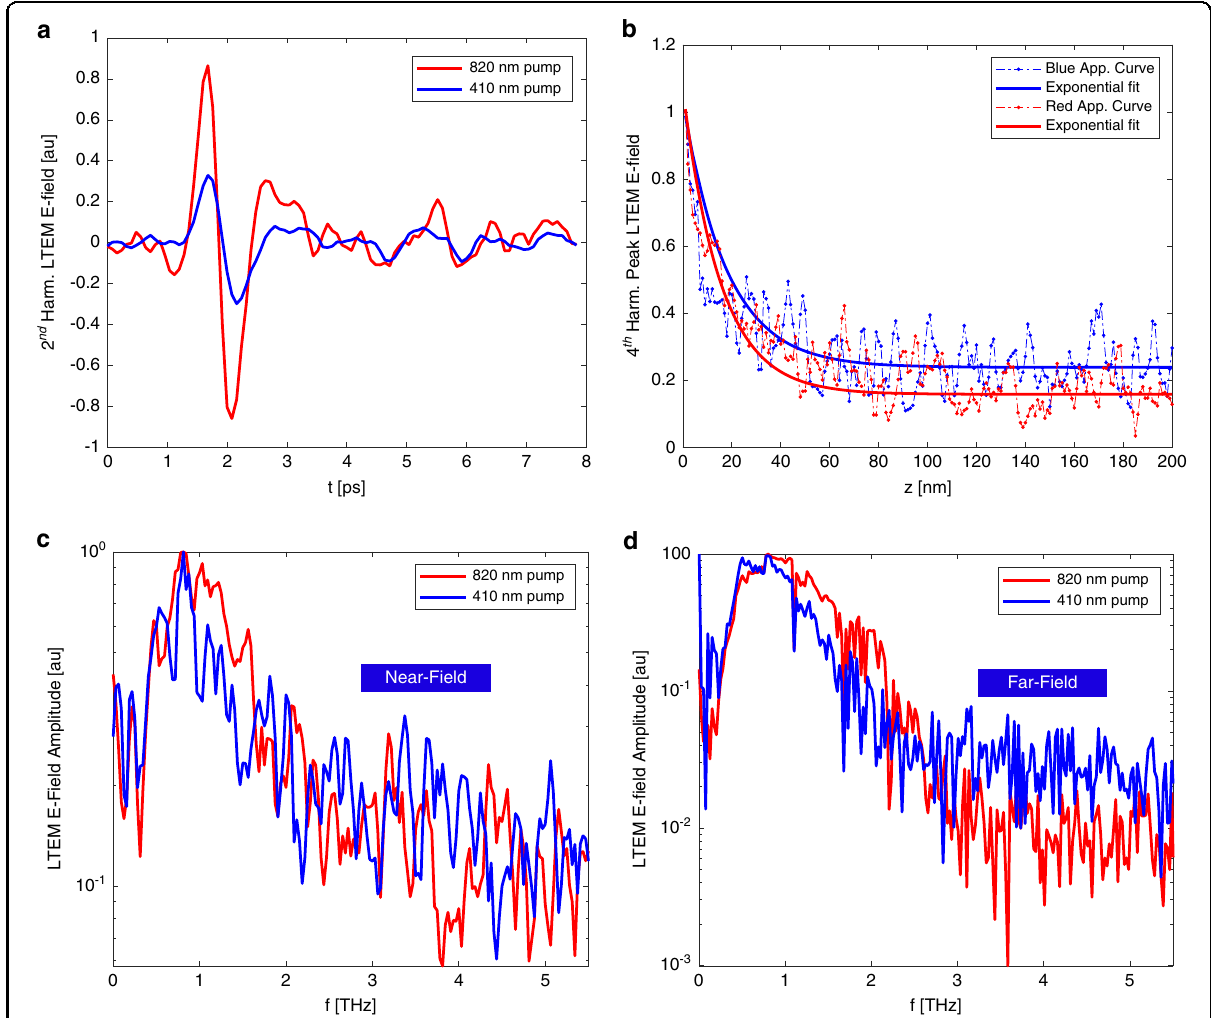
Fig. 2 Near and far fi eld THz emission induced via NIR and blue light from p-InAs. a Time-domain THz emission waveforms from an NIR pump (red) and blue light pump (blue), measured at 2nd harmonic demodulation. b Associated 4th harmonic approach curves showing strong fi eld con fi nement. c Near- fi eld THz emission spectra from p-InAs, from the waveforms shown in ( a ). d Far- fi eld THz emission spectra from p-InAs, referenced to an optical chopper which chops the laser beam at ~3